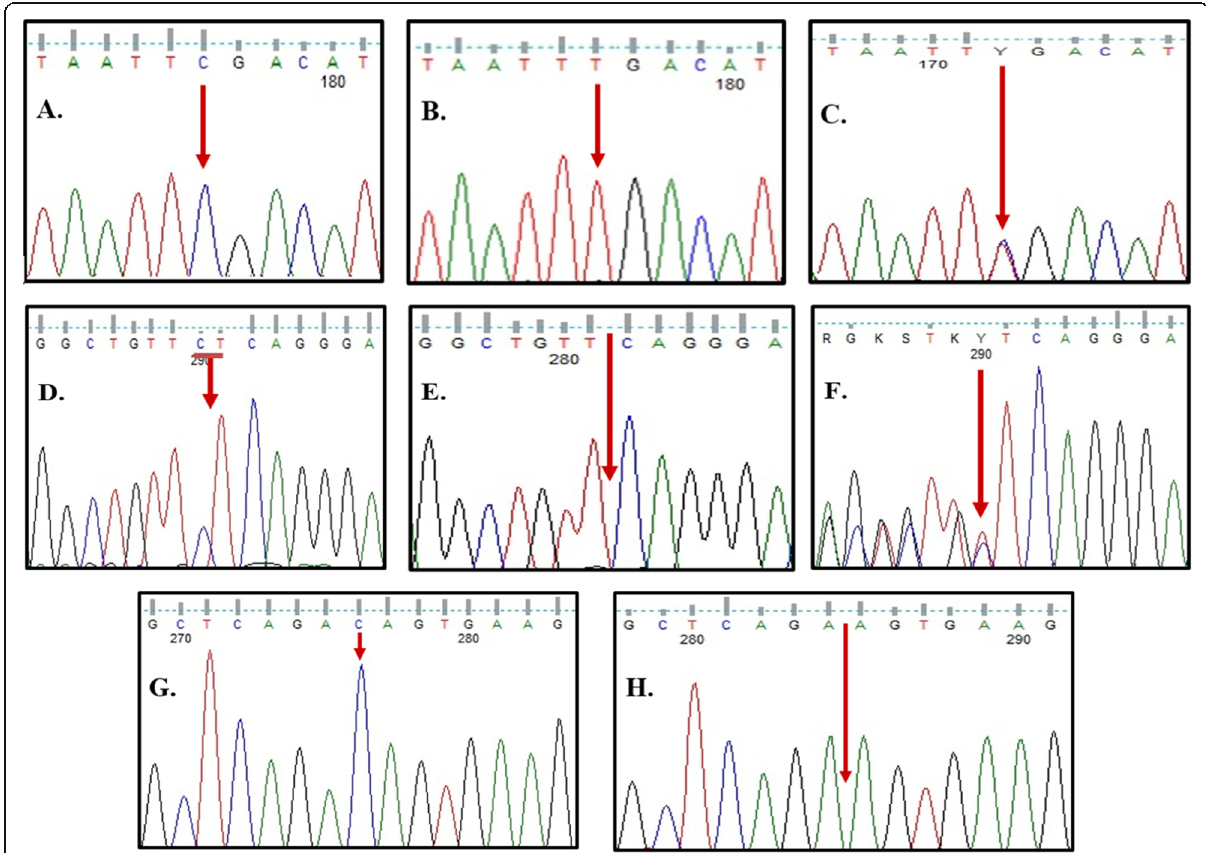
Fig. 6 Sequence chromatograms of exons 13 and 19 of GNPTAB gene . A Wild type of exon 13. B Mutated sequence of exon 13 for patient nos. 1 and 2 (homozygous for p.R587X). C Heterozygous pattern for p.R587X mutation found in the parents. D Wild type of exon 19. E Mutated sequence of exon 19 for patient nos. 3 – 7 (homozygous for p.L1168QfsX5). F Heterozygous pattern for p.L1168QfsX5 mutation found in the